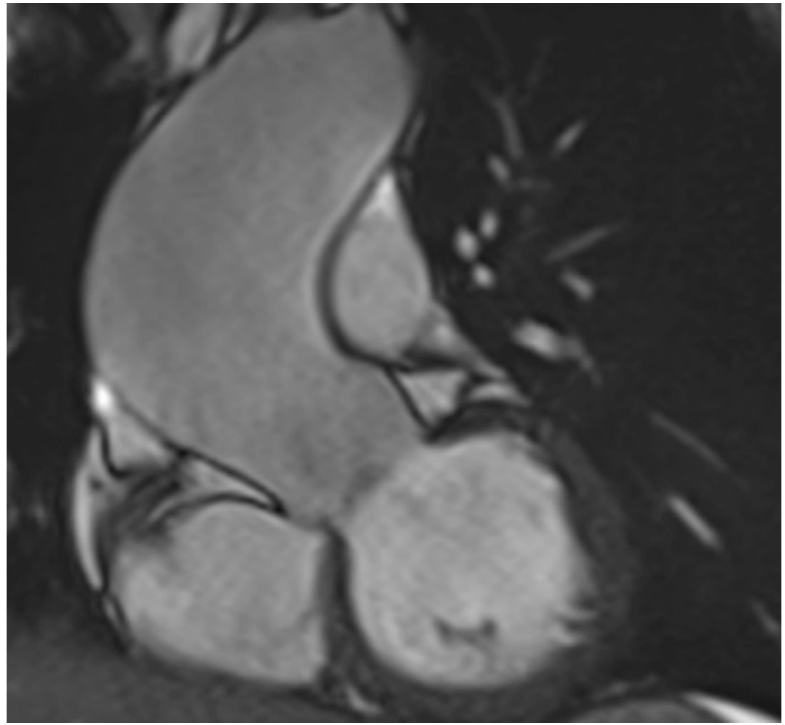
Figure 3. Cardiac magnetic resonance imaging of the left ventricular outflow tract shows a dilation of the ascending aorta in a 16-year-old patient with bicuspid aortic valve. After surgery or in patients with valve dysfunction, CMR may be useful for a more comprehensive assessment of ascending aorta, LV dimension and function and quantifica- tion of AR. Polte and colleagues reported a characterization of severe AR by a regurgitant volume (RVol) > 40 mL (or >20 mL/m 2 ) and a regurgitation fraction (RF) >30% (direct method by aortic flow) and RVol > 62 mL (or >31 mL/m 2 ) and RF > 36% (indirect method by LV and pulmonary stroke volume) [28]. Although CMR studies regarding AR severity